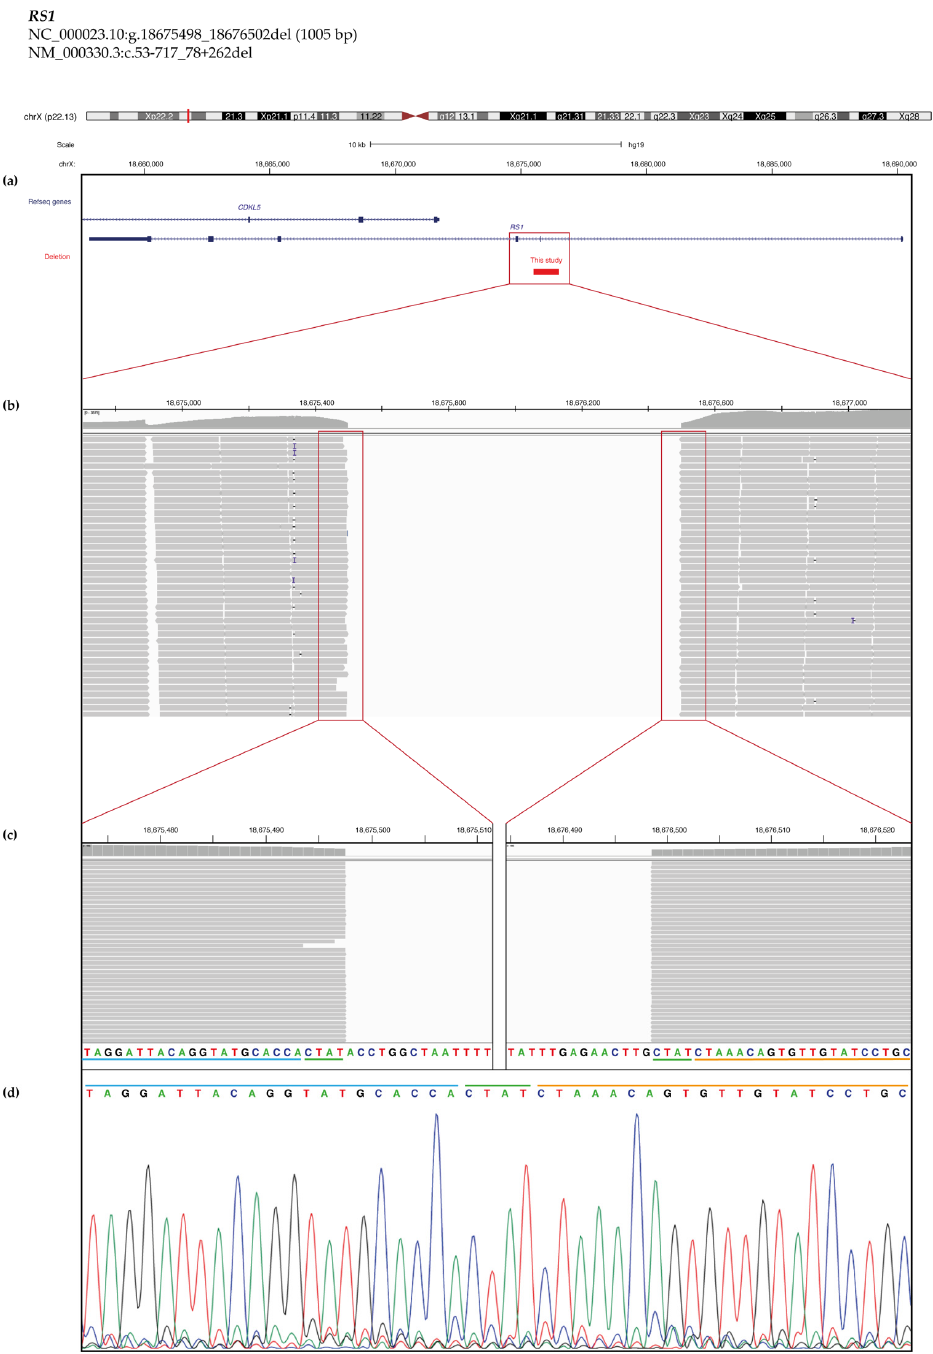
Figure A3. RS1 chrX:g.18675498_18676502del (1005 bp), hemizygous. ( a ) Chromosomal overview and zoom into the RS1 and neighbouring gene region. The red bar shows the position and size of the deletion. ( b ) NGS alignment to the red